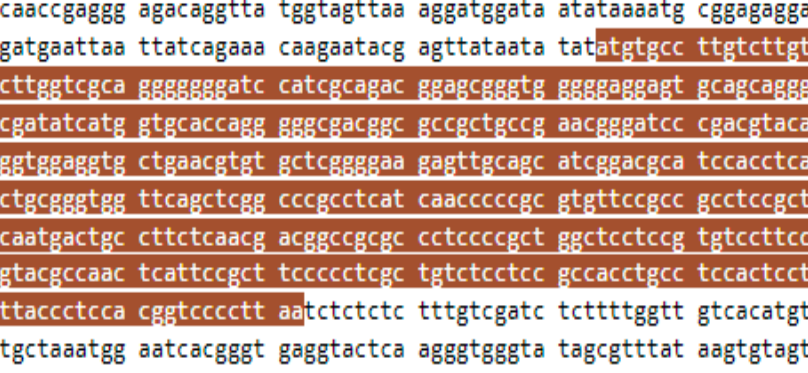
Figure 7. Translated protein sequence of TPD 1-like gene containing 132 amino acids (highlighted). 3.6.2. Subcellular Localization SignalP was used to predict signal peptides from amino acid sequences. Proteins with signal peptides are targeted to the secretory pathway but are not necessarily secreted. The neural networks in SignalP generated three output scores (C-score, Y-score and S-score) for each position in the input sequence. The fi ndings demonstrate that a similar protein lacks a signal peptide. The output scores and their positions were graphically represented. There is no peptide signal when the C, S, and Y score values are less than 0.45. The se- quence from the upstream region of the coding sequence contains a signal peptide with a value of 0.0009 (Sec/SPI), indicating that the signal peptide is located outside the mem- brane (Figure 8). Figure 8. Graphically signal peptide representation of TPD1-like protein.